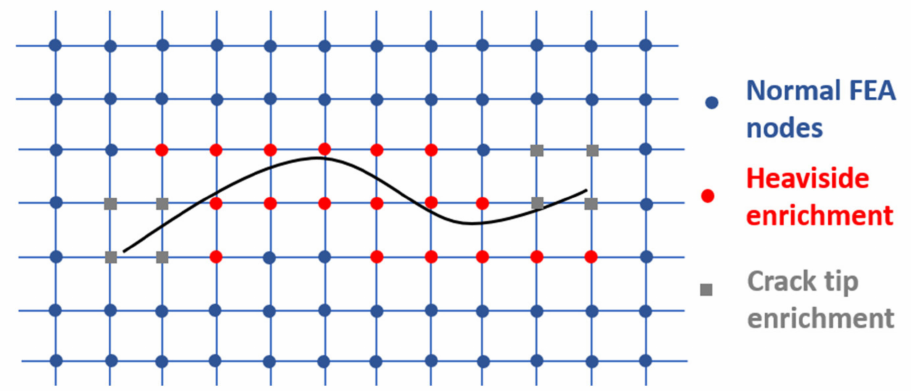
Figure 1. Enriched nodes in